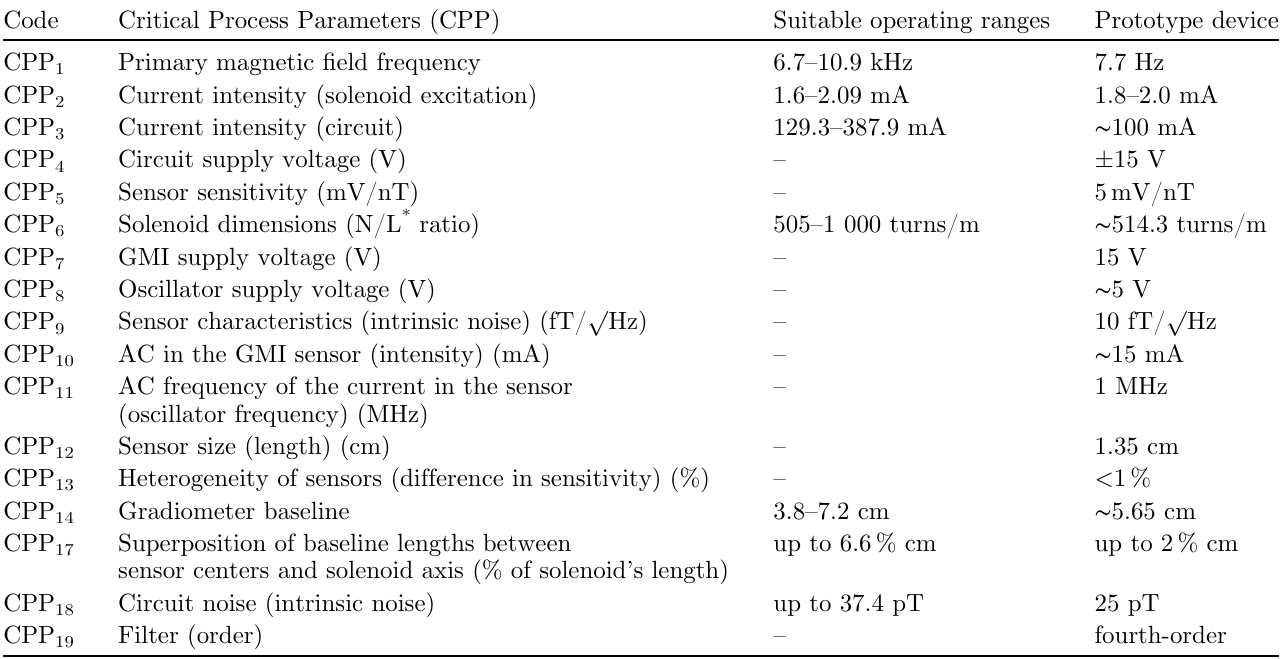
Table 6. Suitable CPP operating ranges that guarantee the best performance of the device.